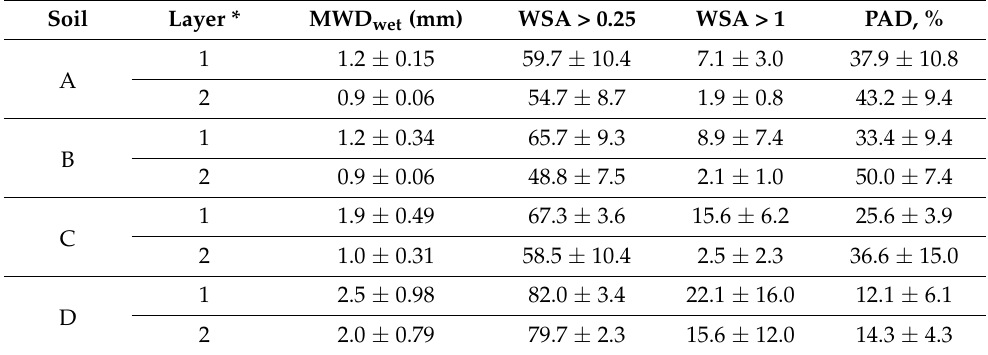
Table 3. Aggregate stability parameters (based on wet-sieving) for different soil groups in a young hummocky moraine landscape (mean values ± standard